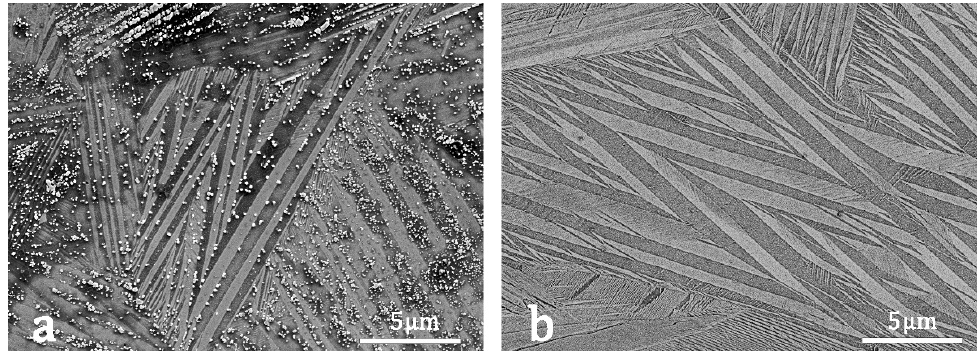
Figure 8. SEM images of the SM–1 treated samples. ( a ) SEM–SE after a slow quench at 100 ◦ C (TT–100). The precipitates of the stable phase γ and out of stoichiometry α phase are observed. ( b ) SEM–BSE after a faster quenching in iced water and aging 24 h at 180 ◦ C (TT–0); only the martensite variants are observed.